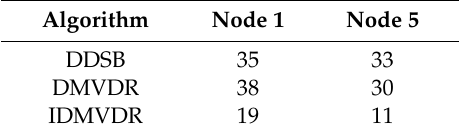
Table 2. The number of iterations when converging in the WASN with N d = 10. Algorithm